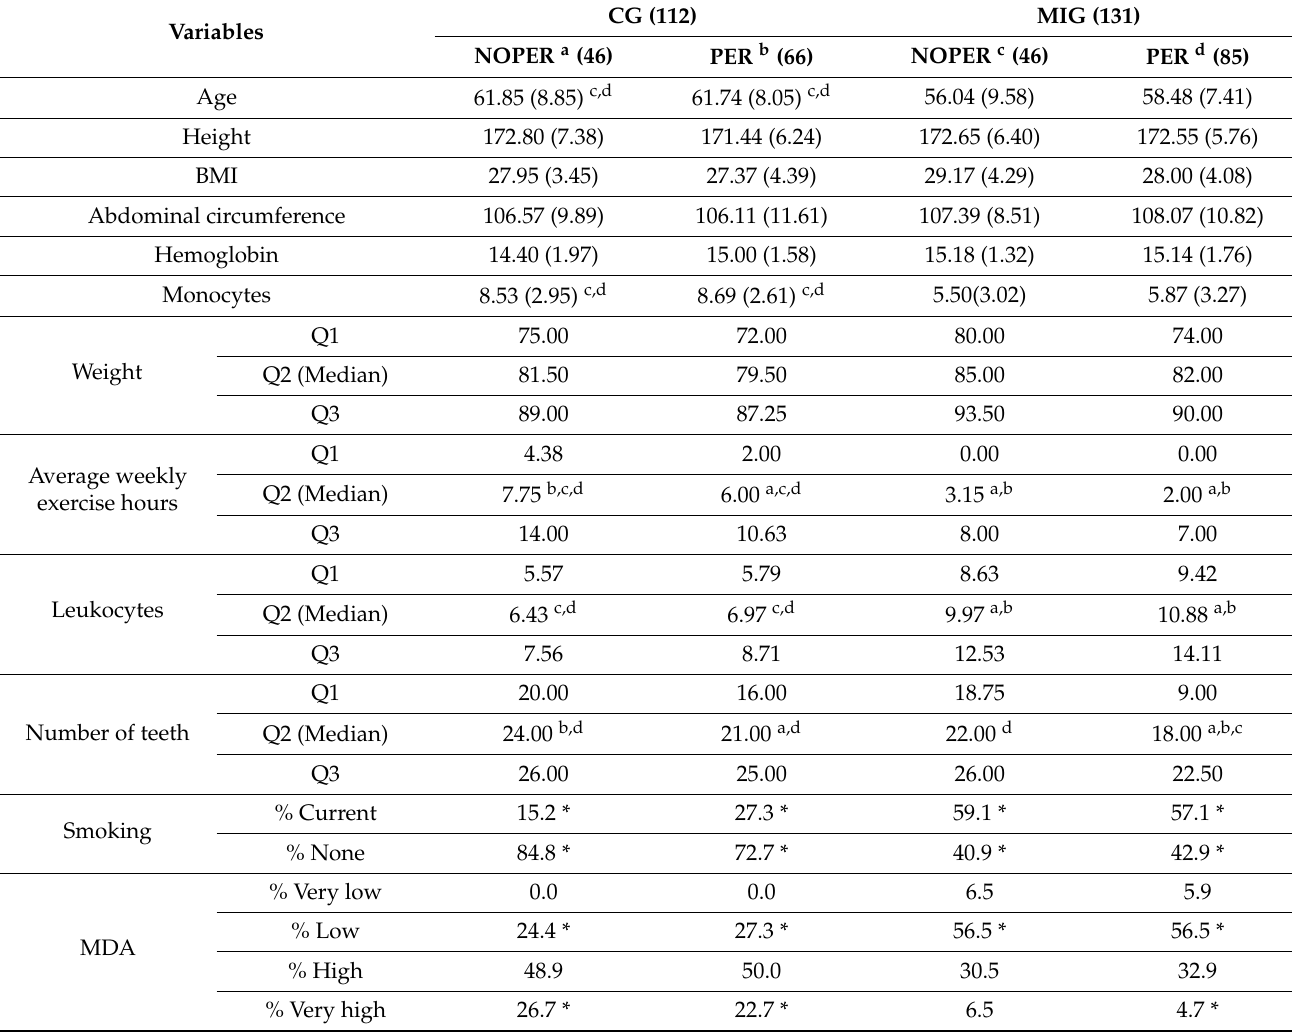
Table 1. General characteristics of the four groups, means (standard deviation), medians, quartiles and percentages. Chi-square, ANOVA, Mann–Whitney U and Kruskal–Wallis